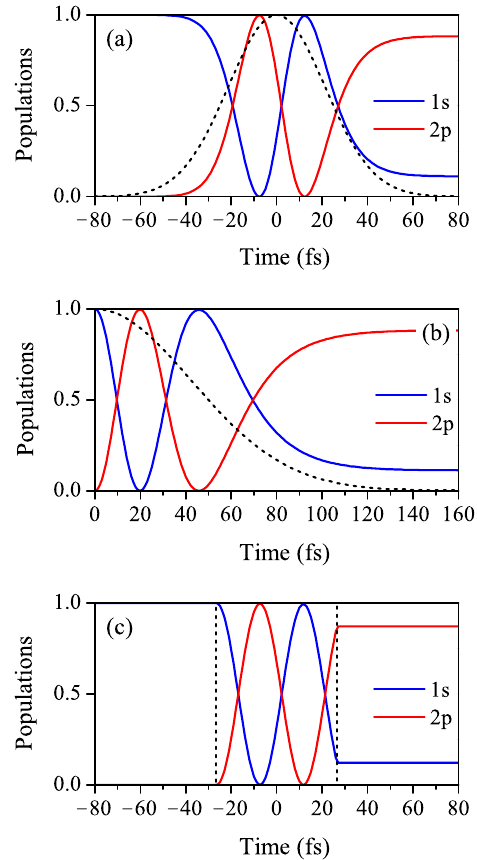
Figure 1. (Color online) The evolution of populations of the ground state (1s) and the excited 2p state during the process of resonant two-photon ionization of hydrogen by: ( a ) Gaussian laser pulse (7) with τ = 30fs, ( b ) half-Gaussian pulse (8) with τ (cid:48) = 60fs and ( c ) rectangular pulse (9) with τ (cid:48)(cid:48) = 26.5868fs, all of carrier frequency ω = 0.375a.u. = 10.203eV, which is resonant for transition 1s → 2p and peak intensity of 1TW/cm 2 . The dashed lines represent the envelopes of the laser pulses. The parameters τ , τ (cid:48) and τ (cid:48)(cid:48) are chosen so that all three pulses have the same value of the pulse area θ = 8.741, for which the populations perform approximately 1.4 Rabi